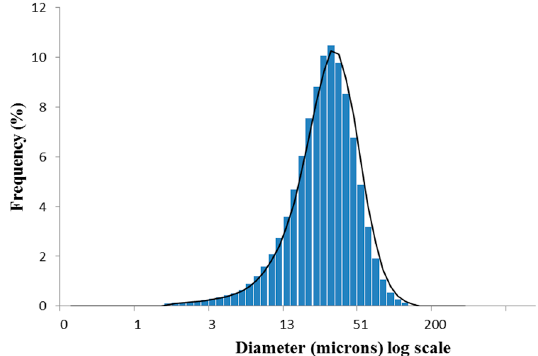
Figure 2. Particle size distribution (PSD) for the Al 6061 feedstock powder. Table 1. Cold spray processing parameters for Al 6061 bulk